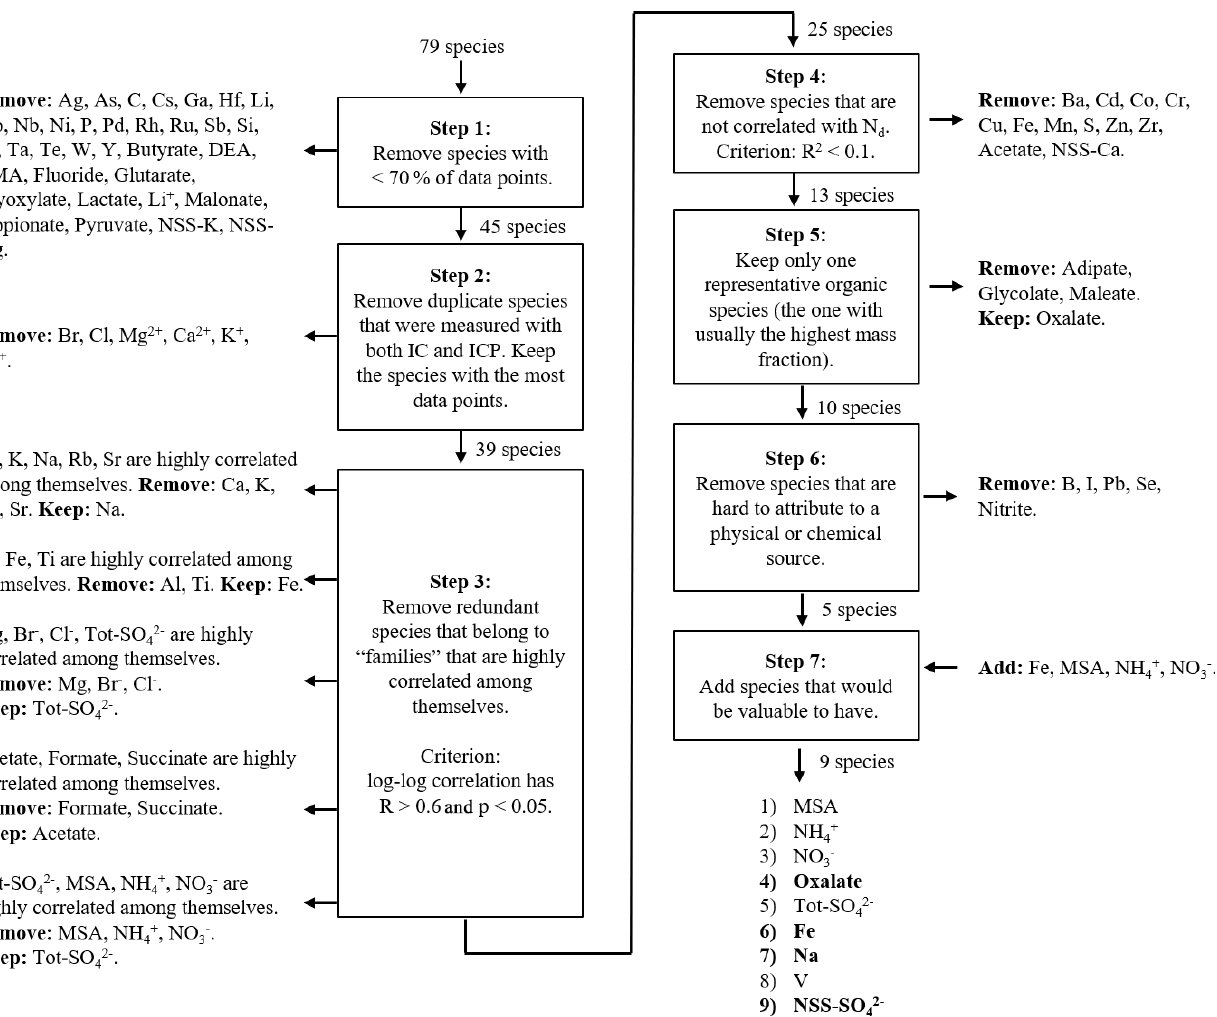
Figure 2. Algorithm used to filter the number of species from 80 to 9. The four species in bold font are the ones used in Sect. 3.3. ICP represents ICP-MS +